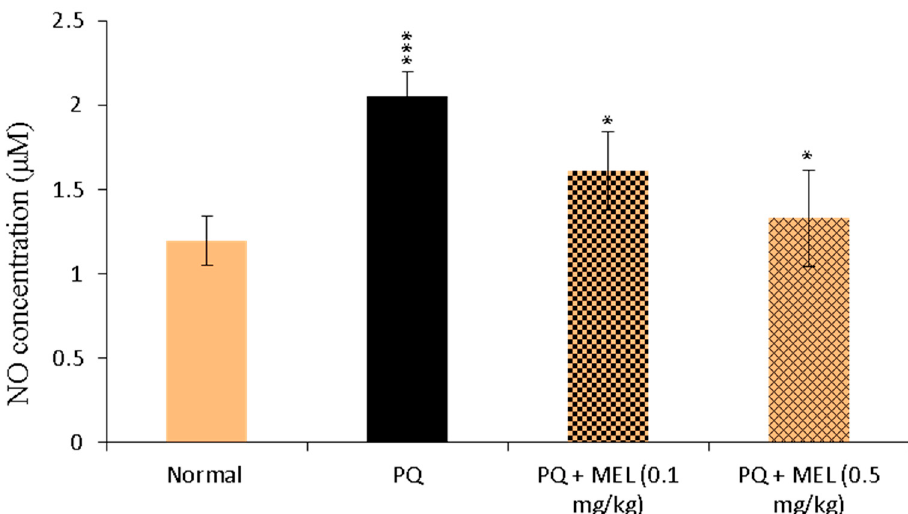
Figure 3. Effect of treatment with melittin (MEL) on the levels of nitric oxide (NO) level in lung tissue homogenate. The level of NO in the lung homogenate was measured according to the Griess method, using NO colorimetric assay. The formed azo dye was measured at 540 nm. NO levels were measured and expressed as µM. Data are presented as mean ±SD. Significantly (* p < 0.05, *** p < 0.001) different from PQ group.